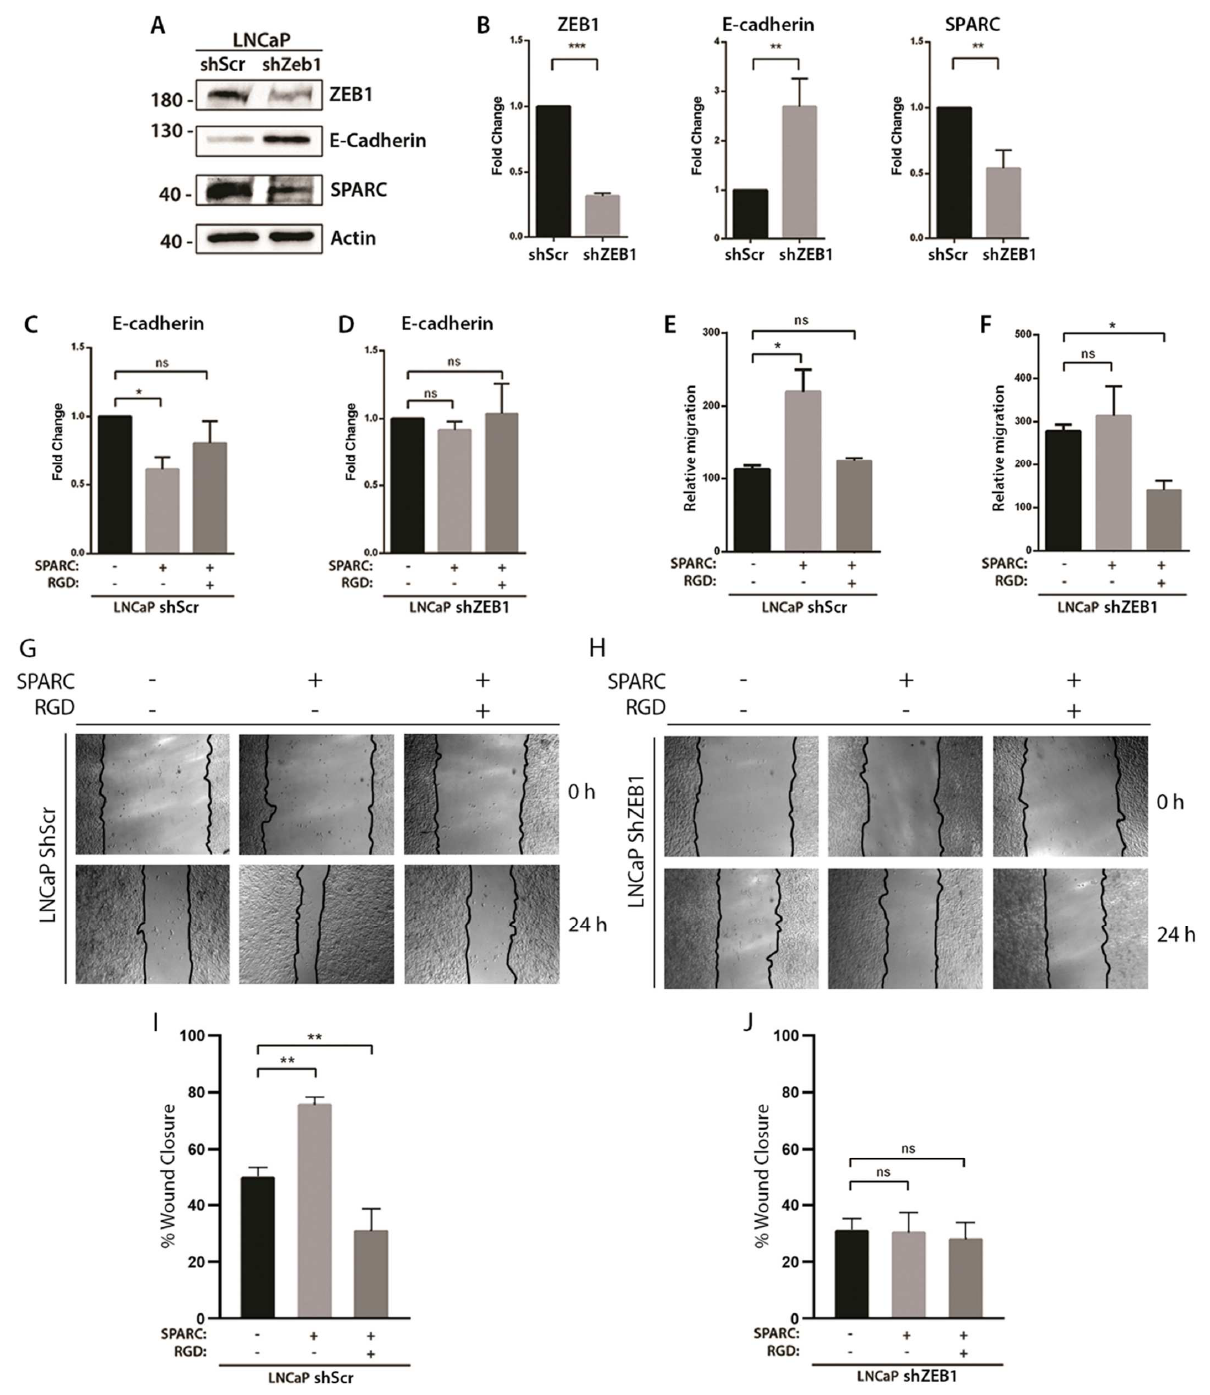
Figure 5. Effect of integrin αvβ3 blockade and ZEB1 knockdown on the SPARC-induced E-cadherin downregulation and enhanced migration ( A ). Representative Western blot of ZEB1, E-cadherin and SPARC in LNCaP cells transduced with a lentiviral vector carrying a short hairpin RNA against ZEB1 (shZEB1) or a scrambled sequence (shScr) ( B ). Quantification of the optic density of the West- ern blot shown in ( A ). Protein expression normalized to β-actin and control cells (shSCR) ( C , D ). Relative expression of E-cadherin measured by RT-qPCR in LNCaP shScramble ( C ) and LNCaP shZEB1 cells stimulated with 1 μg/mL SPARC and 50 μM RGD for 6 h. E-cadherin expression